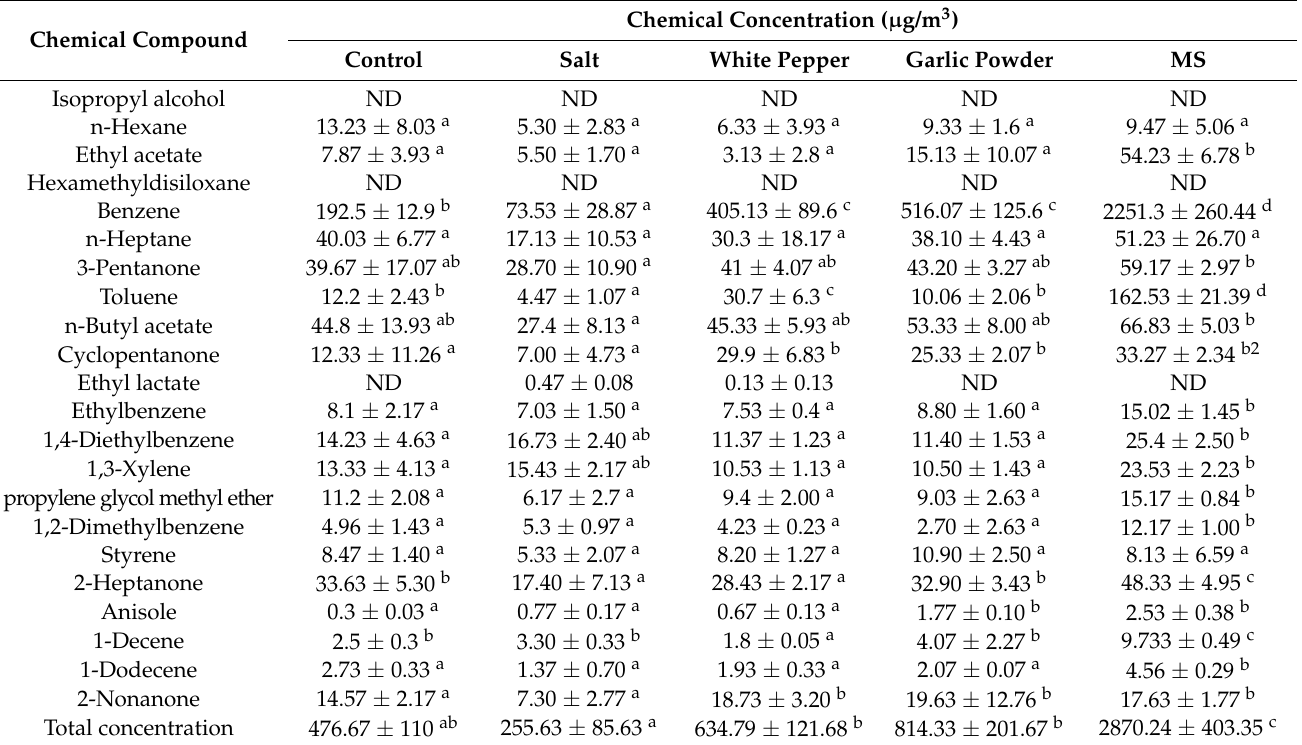
Table 6. VOC concentrations in the cooking fumes emitted from the grilling of meat marinated with different additives.